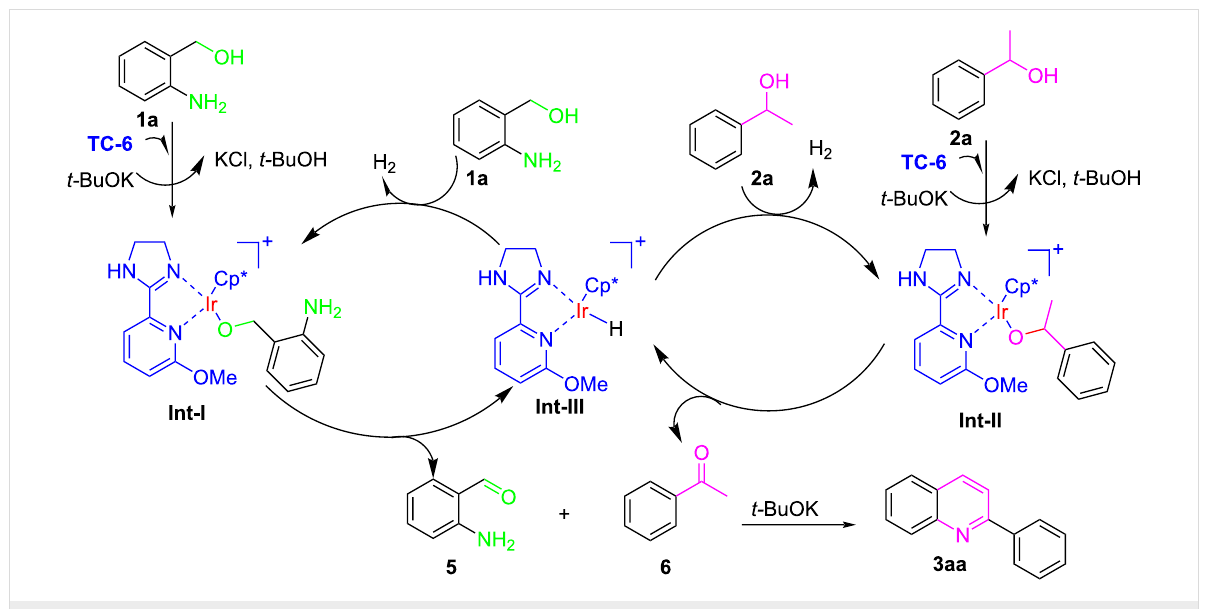
Figure 5: A speculated possible mechanism.